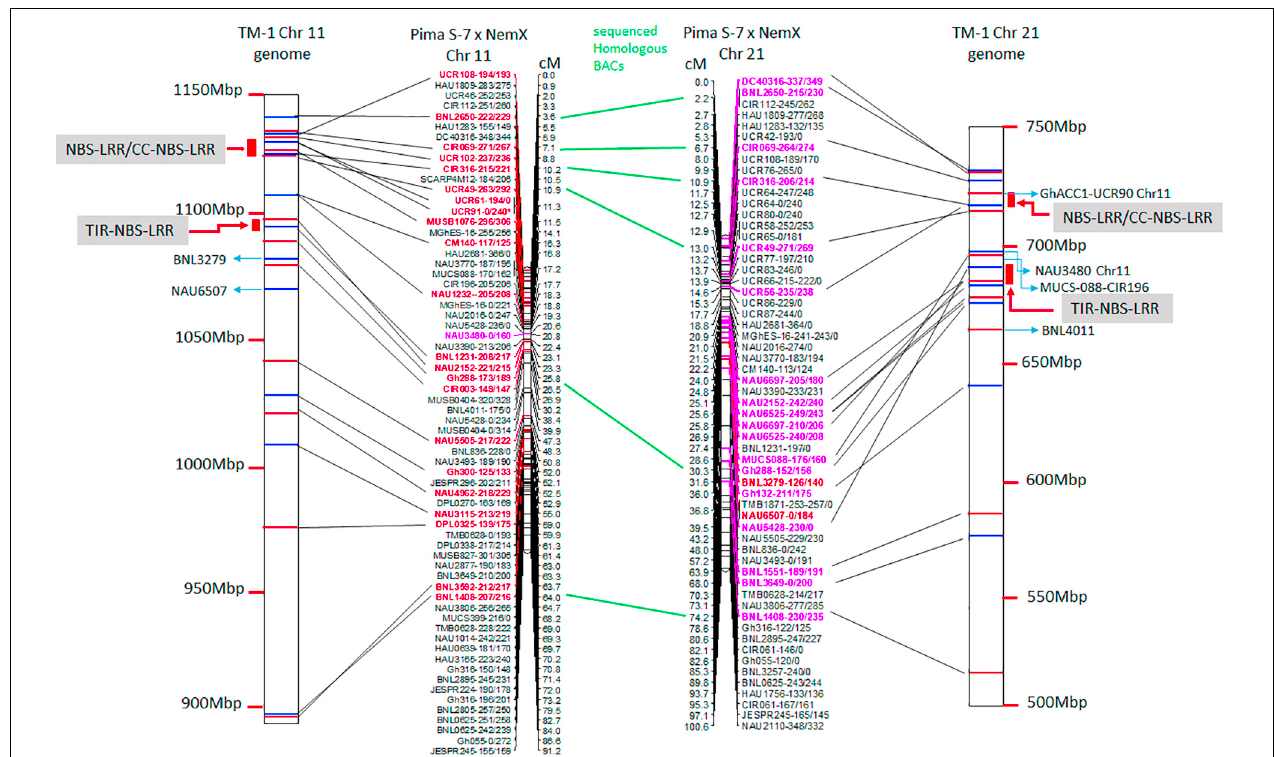
FIGURE 1 | Alignment of TM-1 reference genome (https://www.cottongen.org/analysis/189) with linkage maps of Chr 11 and its homoeologous Chr 21 using an interspecific [Pima S-7 ( Gossypium barbadense ) × Upland Acala NemX ( G. hirsutum )] RIL population (Wang et al., 2017). SSR markers in red are mapped to TM-1 Chr 11 genome and those in pink are mapped to TM-1 Chr 21 genome.